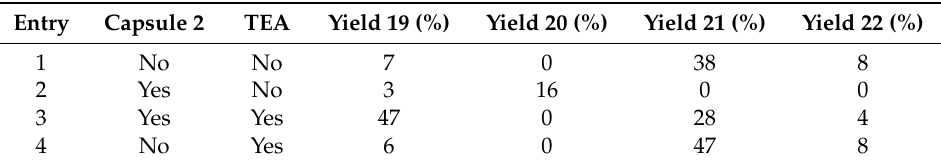
Table 5. Gold-catalyzed conversion of 4-phenyl-1-butyne 18